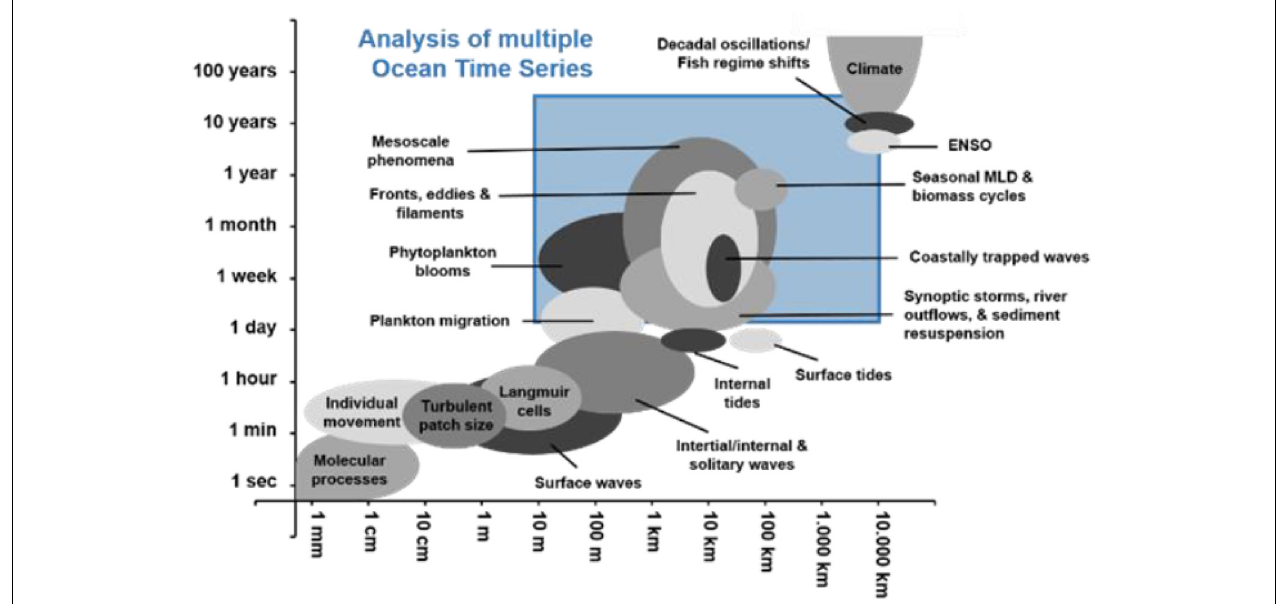
FIGURE 1 | Temporal and spatial scales of a range of ocean processes. The blue square highlights the range of space and time scales that can be addressed by ship-based time series measurements (from Valdés and Lomas,